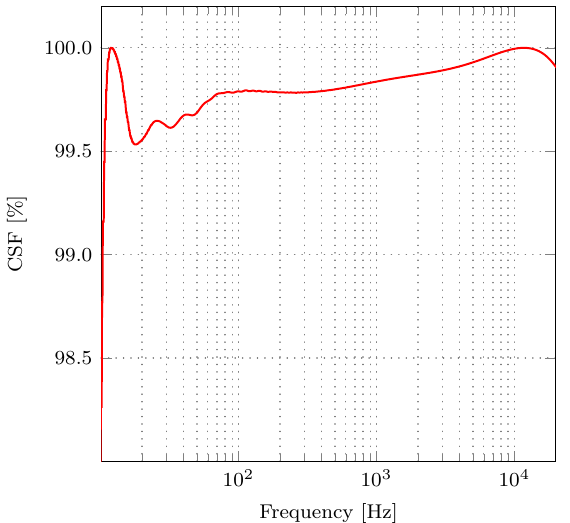
Figure 8. Cross signature scale factor (CSF) of frequency responses of the proposed and reference A-weighting